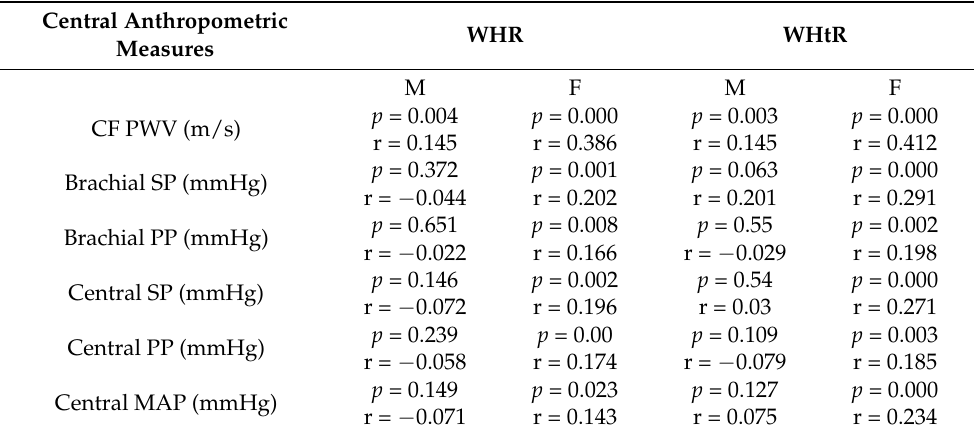
Table 3. Correlation analysis of WHR and WHeightR with pressure wave indices in males and females.